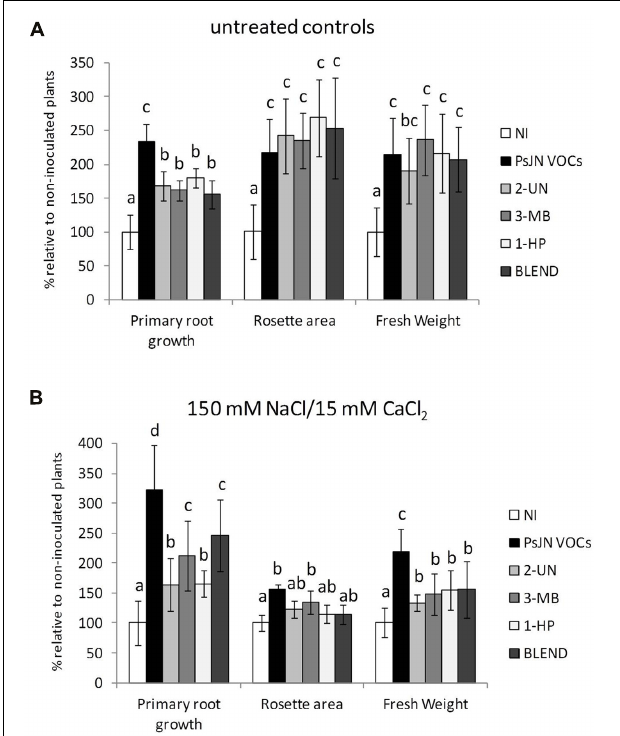
FIGURE 6 | Stimulation of A. thaliana growth and salt tolerance by individual volatile compounds and a volatile blend emitted by P. phytofirmans PsJN. Root growth, rosette area and fresh weight were determined for A. thaliana col-0 grown in vitro on MS 1 / 2 agar medium without bacterial inoculum, placed in front of an independent MS 1 / 2 agar plate inoculated with 1 × 10 6 CFU/ml of P. phytofirmans (PsJN-VOCs), non-inoculated MS 1 / 2 agar (N. I.), or in the presence of different amounts of volatile compounds added per plate. Tested compounds were 100 ng of 2-undecanone (2-UN); 1-heptanol (1-HP); 3-methyl-butanol (3-MB); or a 1:1:1 blend of the three compounds (BLEND). Plants were transferred at 14 DAS to fresh MS 1 / 2 agar with no added NaCl or CaCl 2 (untreated controls) (A) , or MS 1 / 2 agar with 150/15 mM NaCl/CaCl 2 (B) . Growth parameters were registered at 21 DAS. Columns show mean values relative to N. I. controls, and the error bars indicate standard deviations from experiments with 24 plants analyzed for each compound treatment. Asterisks indicate statistically significant differences from the control (N. I.) treatment within each compound (One way ANOVA Tukey’s HSD tests; p <